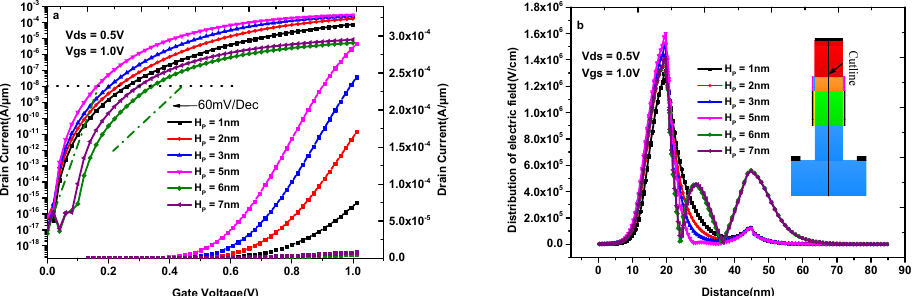
Figure 7. ( a )Transfer characteristics of DMG-HD-VTFET with different source-pocket thicknesses; ( b ) electric field distribution with different source-pocket thicknesses.